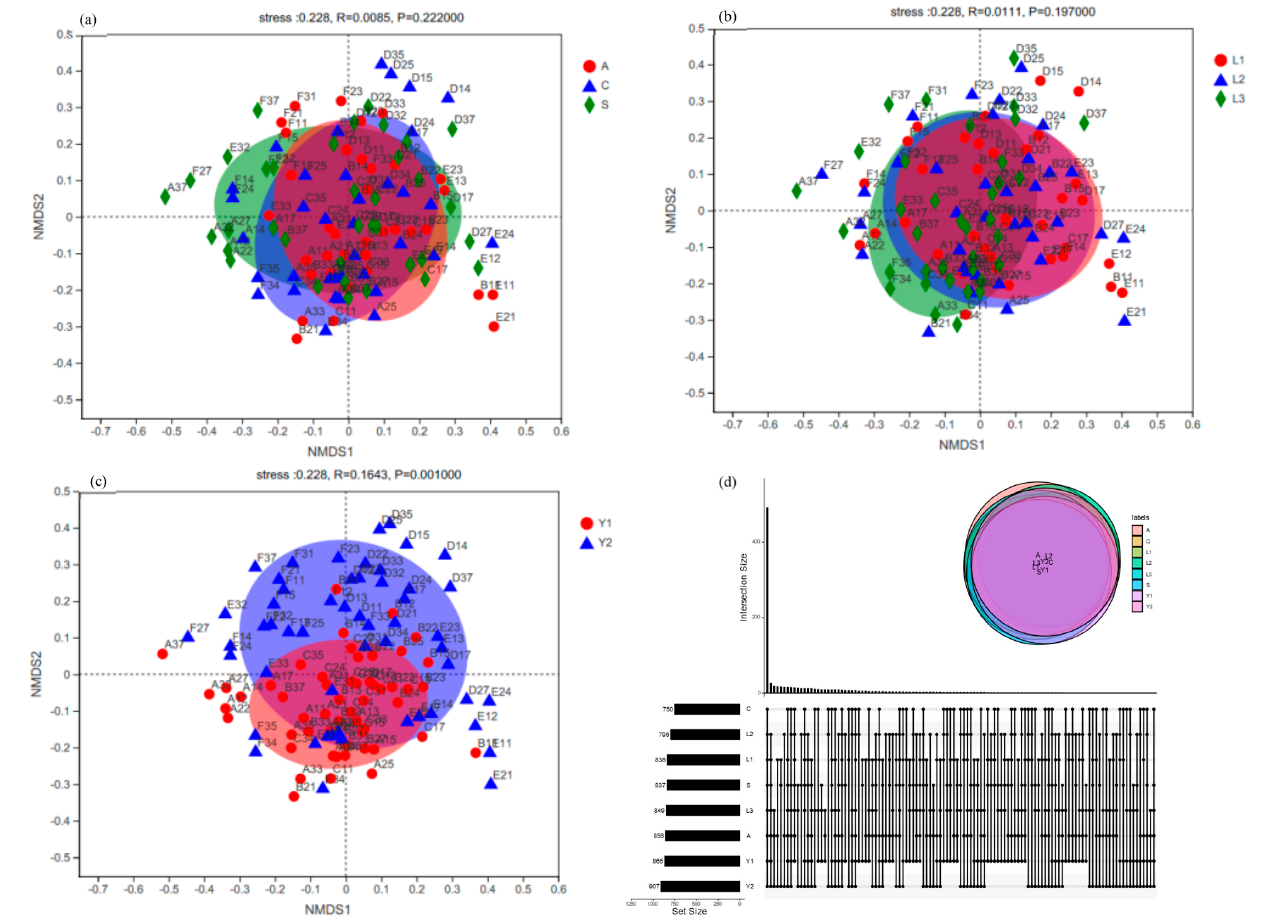
Figure 6. Venn diagram of fungi based on OUT levels in orientation ( a ), vertical position ( b ) and storage time ( c ) and non-metric multidimensional scale analysis (NMDS) for unique and shared fungi OUTs ( d ).